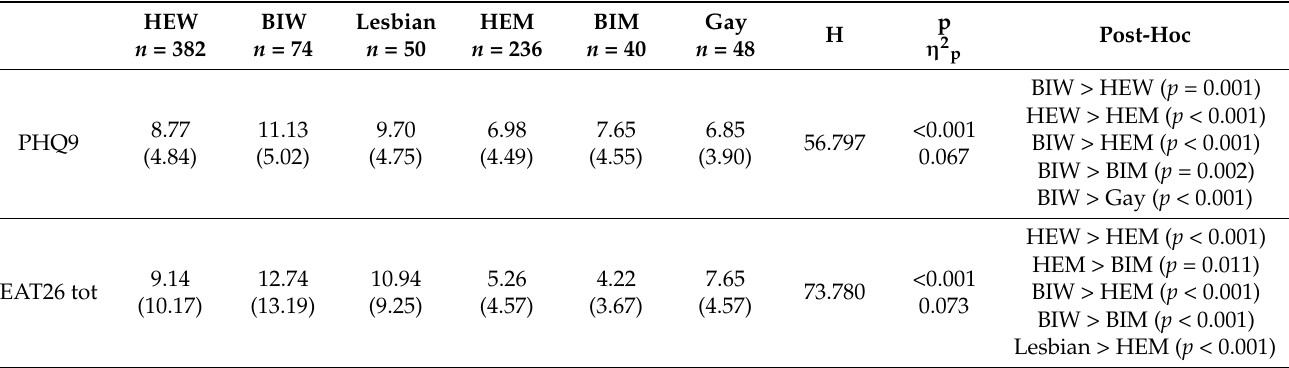
Table 2. Psychological evaluation of the